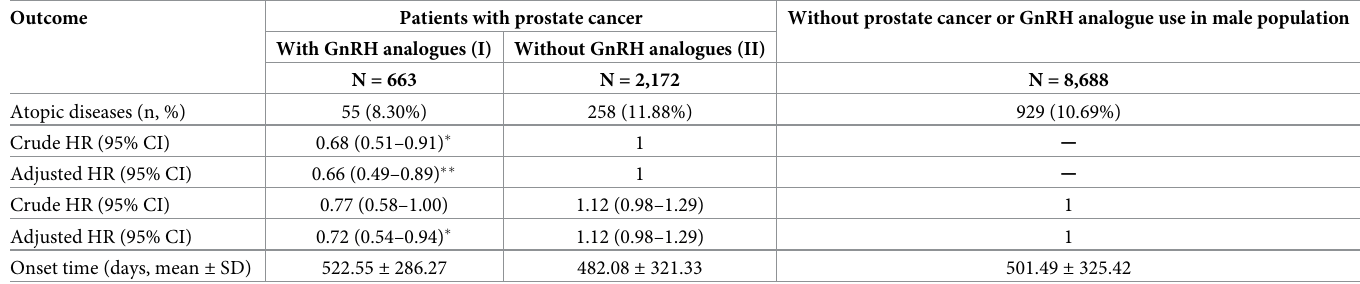
Table 2. Hazard ratios for atopic diseases in patients with prostate cancer during 3-year follow-up period.